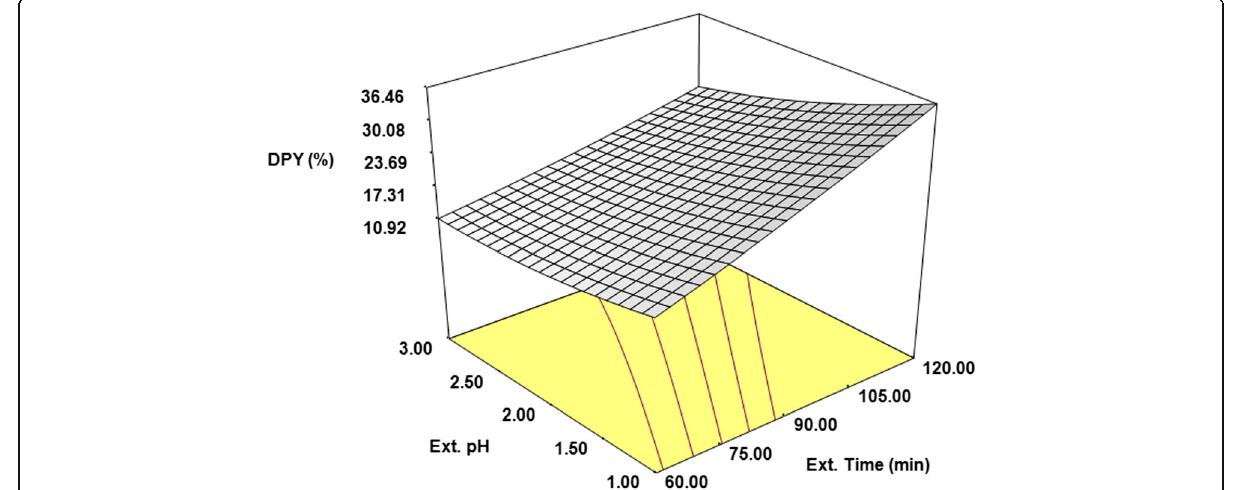
Fig. 4 Response surface plot of the effect of extraction time and extraction pH on dried pectin